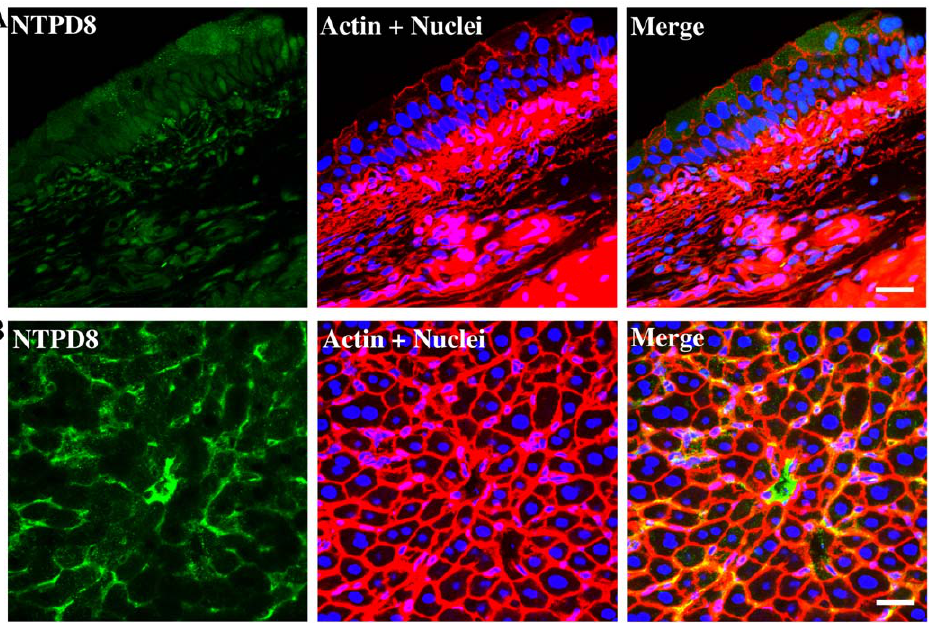
Figure 7. Immunolocalization of NTPD8 in bladder and liver. Cryosections of mouse bladders and livers were labeled with antibodies to NTPD8 (green), rhodamine phalloidin to label the actin cytoskeleton (red) and Topro-3 to label nuclei (blue). Color merged panels are shown on the right. A) NTPD8 staining of bladder, B) NTPD8 staining of liver. White scale bars =25 m m.